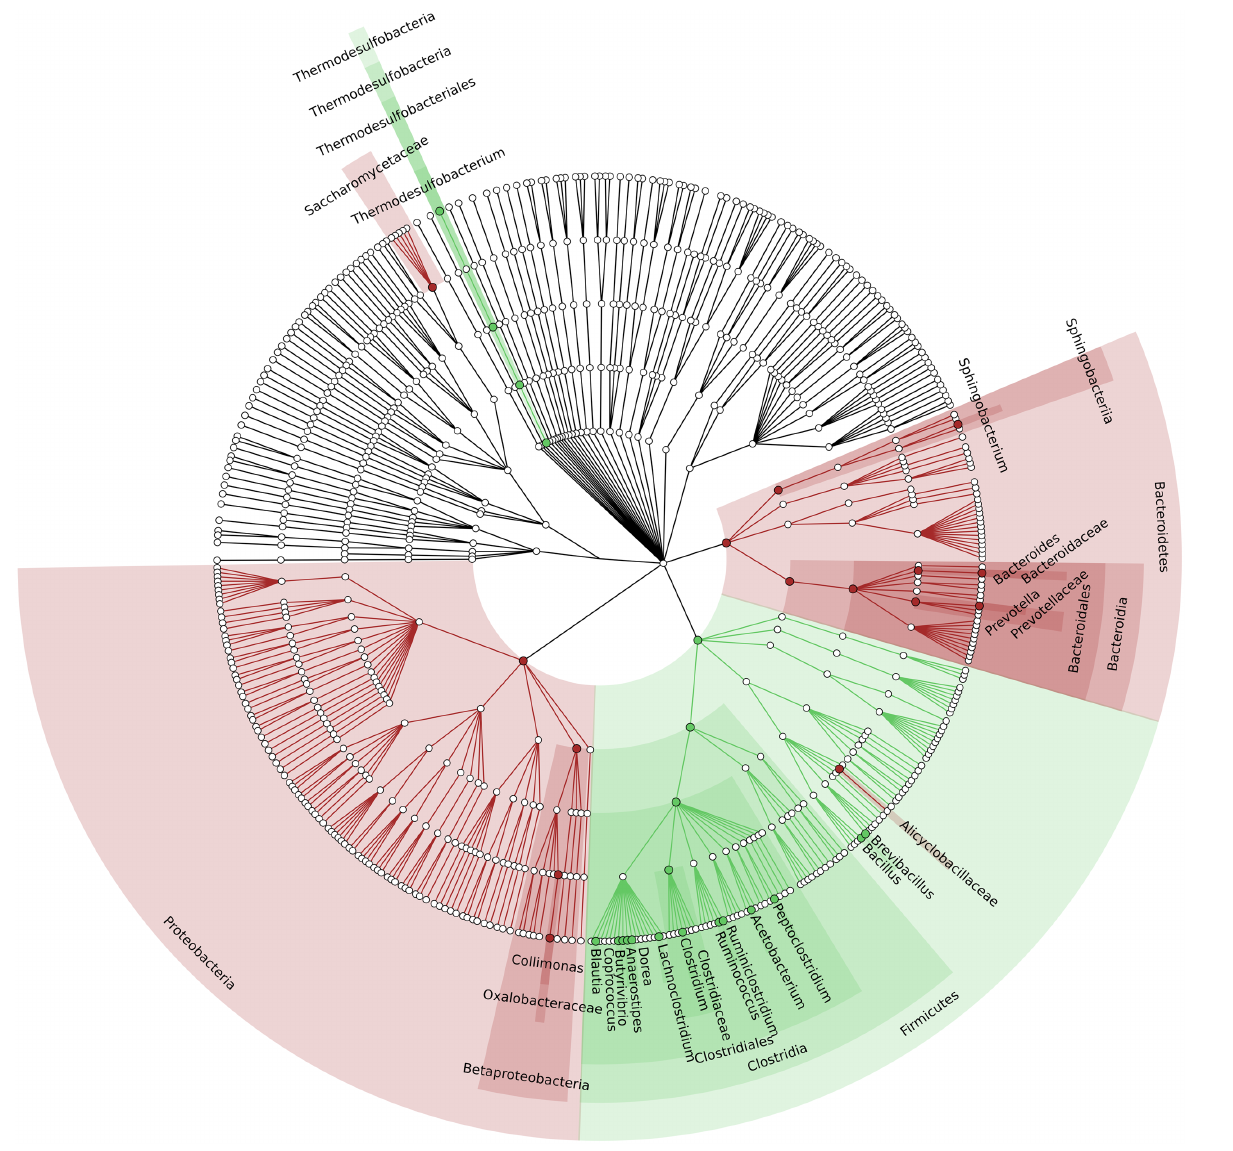
FIGURE 3 | Cladogram illustrating the distribution of taxa with differential abundance between CCs and feces, according to MP data. Each dot represents an identified taxon, with taxa higher in CCs colored in green, and those higher in feces in